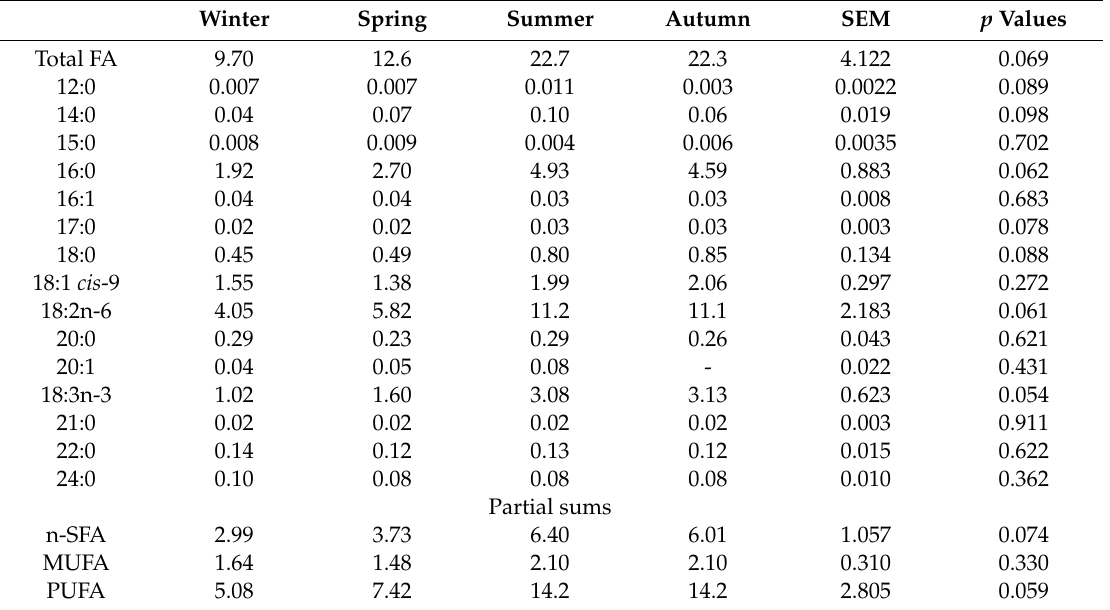
Table 4. E ff ect of season on fatty acid composition (mg / g DM) of C. ladanifer seed heads. Winter Spring Summer